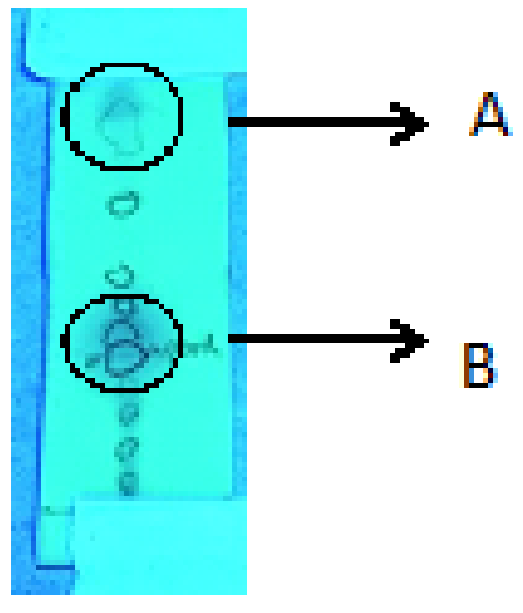
Figure 1 : TLC from n-hexane extract of Andrographis paniculata